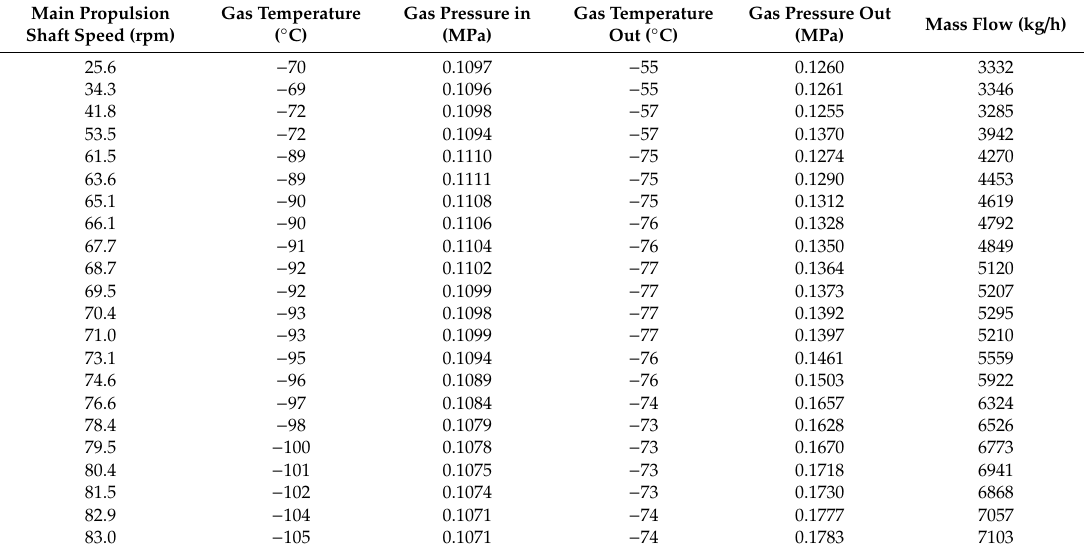
Table 2. Measured values of natural gas before and after low-duty turbo